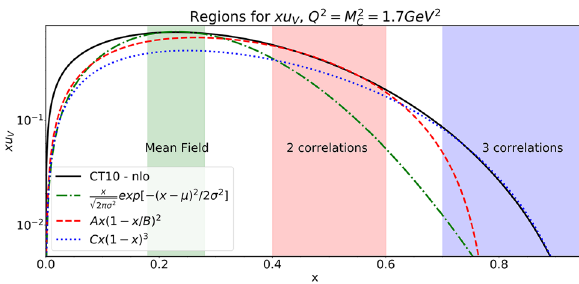
Fig. 2 The graph shows the comparison of the x weighted valence u- quark distribution fitted by three analytic functions corresponding to the mean field, 2q- and